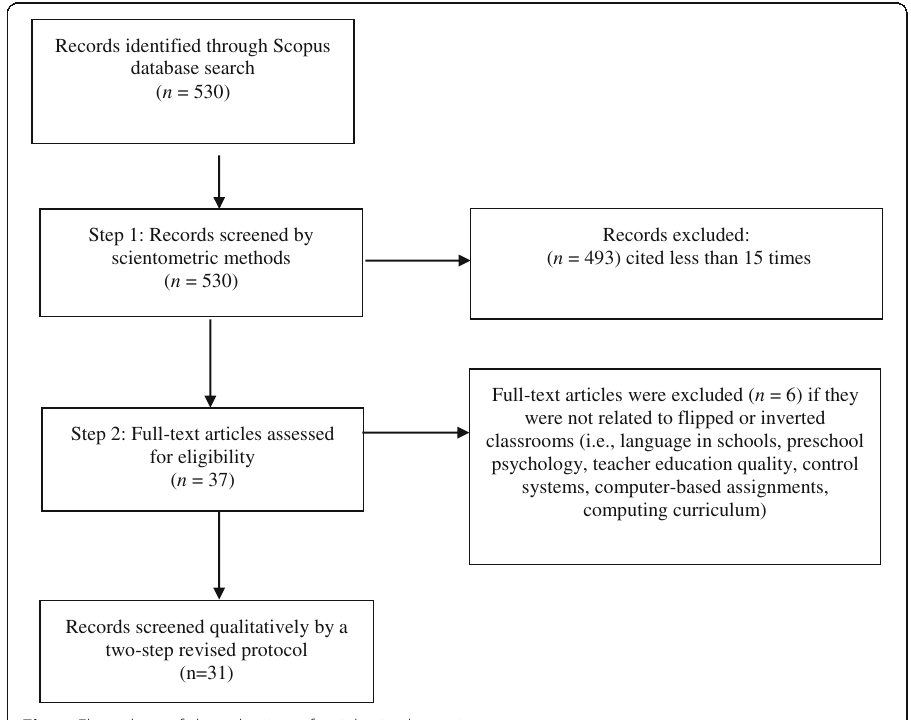
Fig. 1 Flow chart of the selection of articles in the review